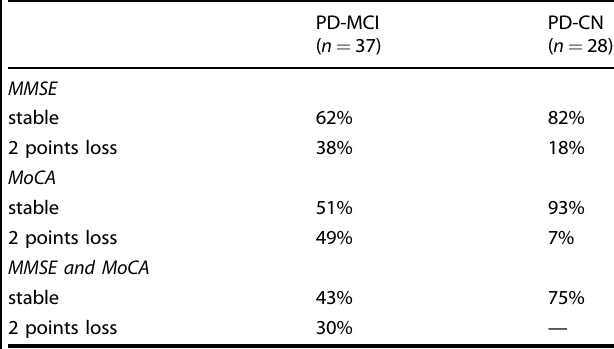
Table 3. Prevalences of PD-MCI and PD-NC patients who